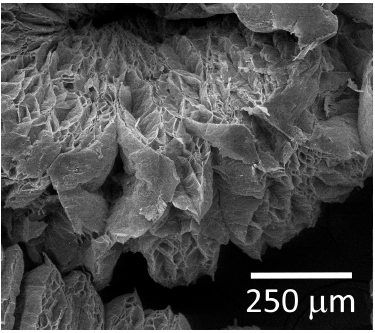
Figure 3. Scanning electron microscopy (SEM) image of expanded graphite.